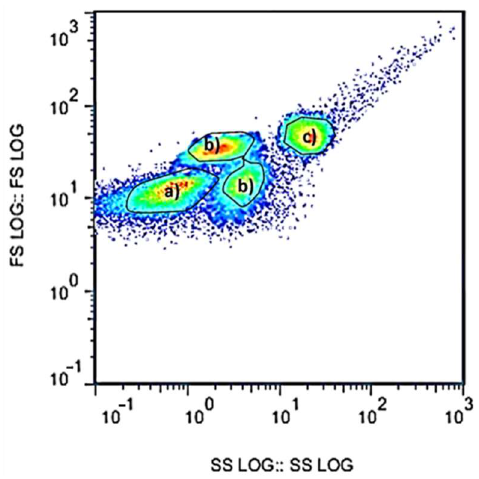
Figure 9. Cytometry results from individual species in the same graph: ( a ) Nannochloropsis gaditana ; ( b ) Isochrysis galbana ; ( c ) Tetraselmis suecica .